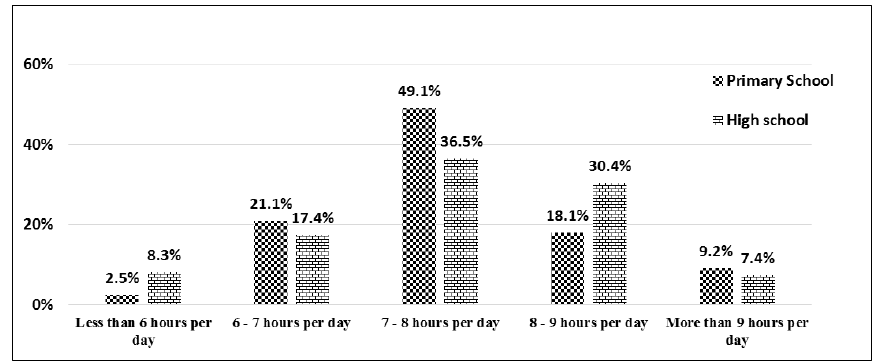
Figure 4. Distribution of children’s sleep amount among primary and high school students.